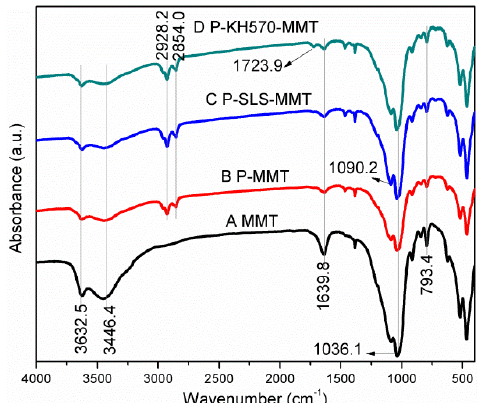
Figure 2. Fourier-transform infrared (FTIR) spectra of ( A ) sodium montmorillonite (MMT), ( B ) P-MMT, ( C ) P-SLS-MMT, and ( D ) P-KH570-MMT.